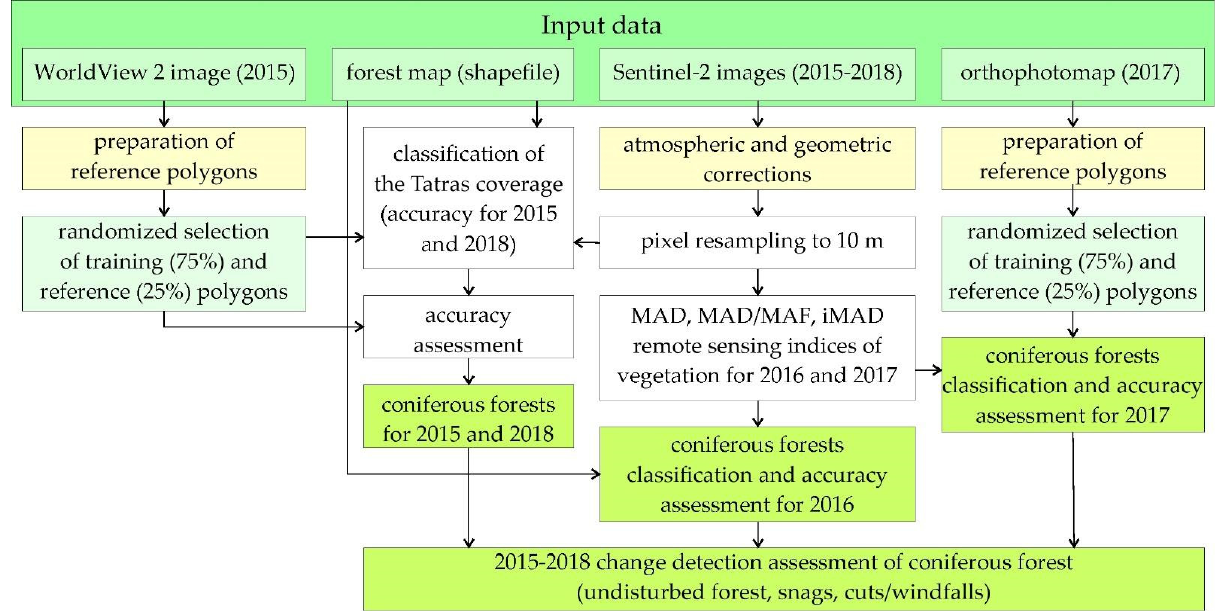
Figure 2. Research schema. Figure 2. Research Table 1. Number of reference polygons and pixels by a class for the 2015 Sentinel-2 image classifi- cation.